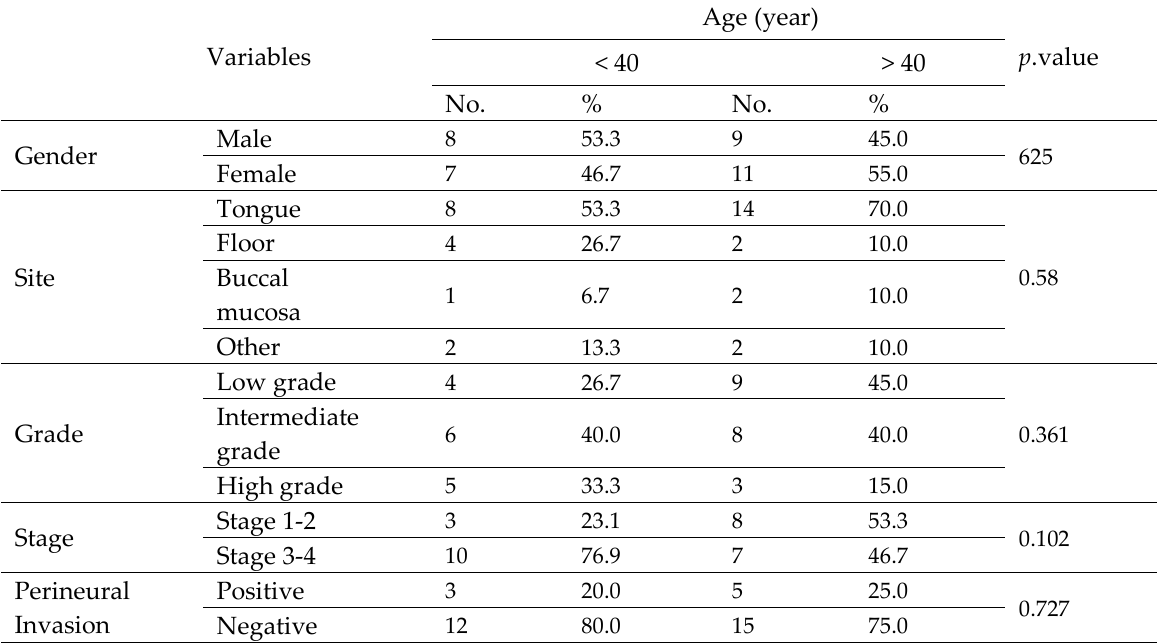
Table 1 : Clinicopathological comparison of the study